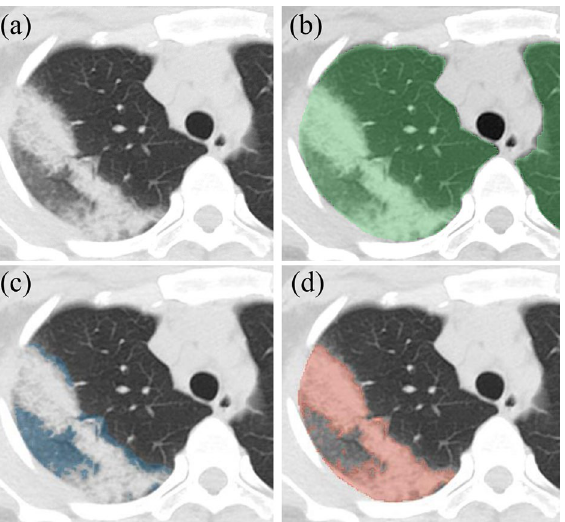
Figure 1. Axial CT images of COVID-19 opacity in right upper lobe, resulting in a part of GGO and a part of consolidation. ( a ) Non-contrast axial chest CT passing through right upper lobe opacity. ( b ) Overlaid AI whole lung segmentation (green). ( c ) Overlaid GGO segmentation alone (blue). ( d ) Overlaid consolidation segmentation alone